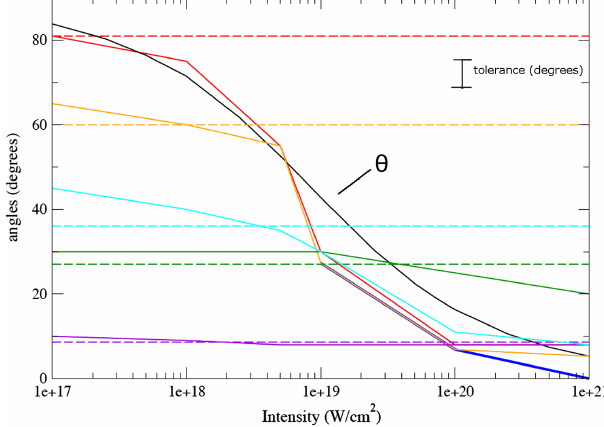
FIG. 3. Electron emission angles as a function of the laser intensities, for different droplets sizes, compared with available models. Color corresponds to different cluster radii, namely: red ¼ 100 nm, orange ¼ 200 nm, cyan ¼ 300 nm, green ¼ 500 nm, violet ¼ 1 micron. Solid lines represent simulation points, dashed horizontal lines Mie theory prediction. Black and blue line represent nonlinear ponderomotive scattering prediction and deviation formula of Eq. (3), respectively. The observed divergence with respect to central direction of the bunches is about 5